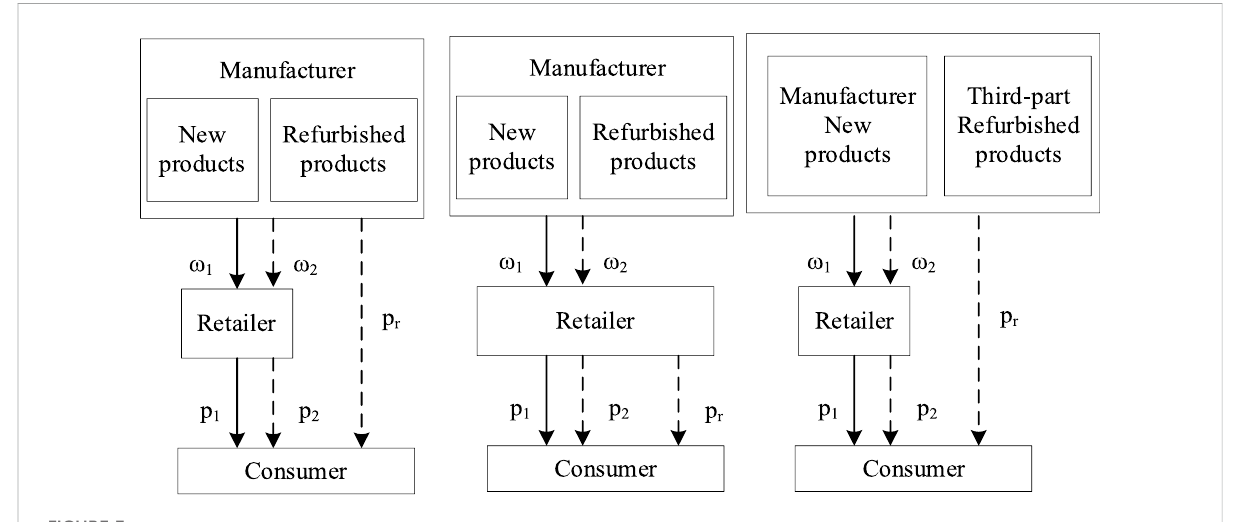
FIGURE 3 Indicates the different channel structures in the two-period medical supply